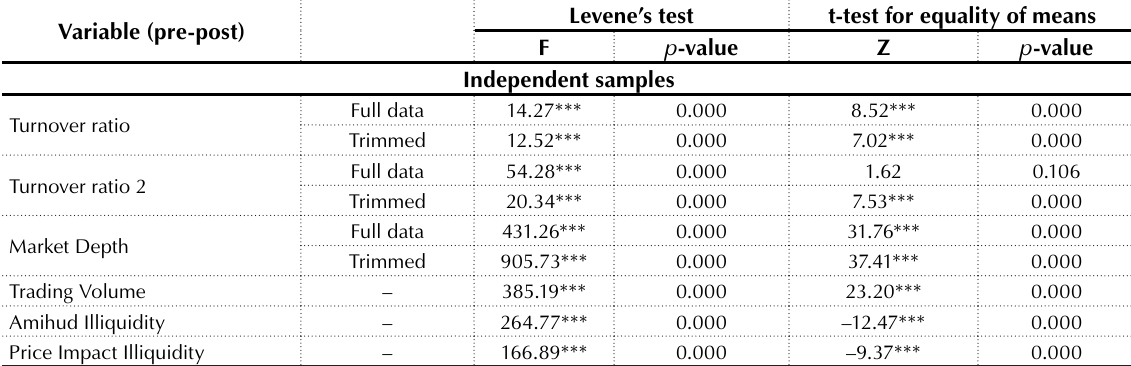
Table 5. Student t-test of the five liquidity measures and three trimmed measures Variable